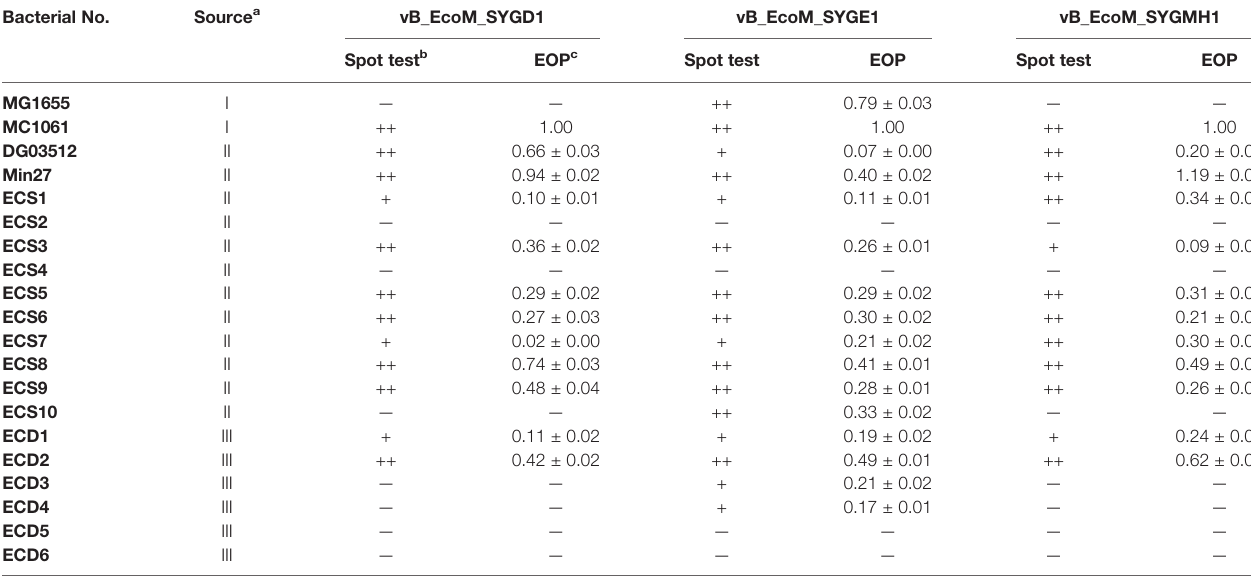
TABLE 1 | The host range and EOP of vB_EcoM_SYGD1, vB_EcoP_SYGE1, and vB_EcoM_SYGMH1. Bacterial